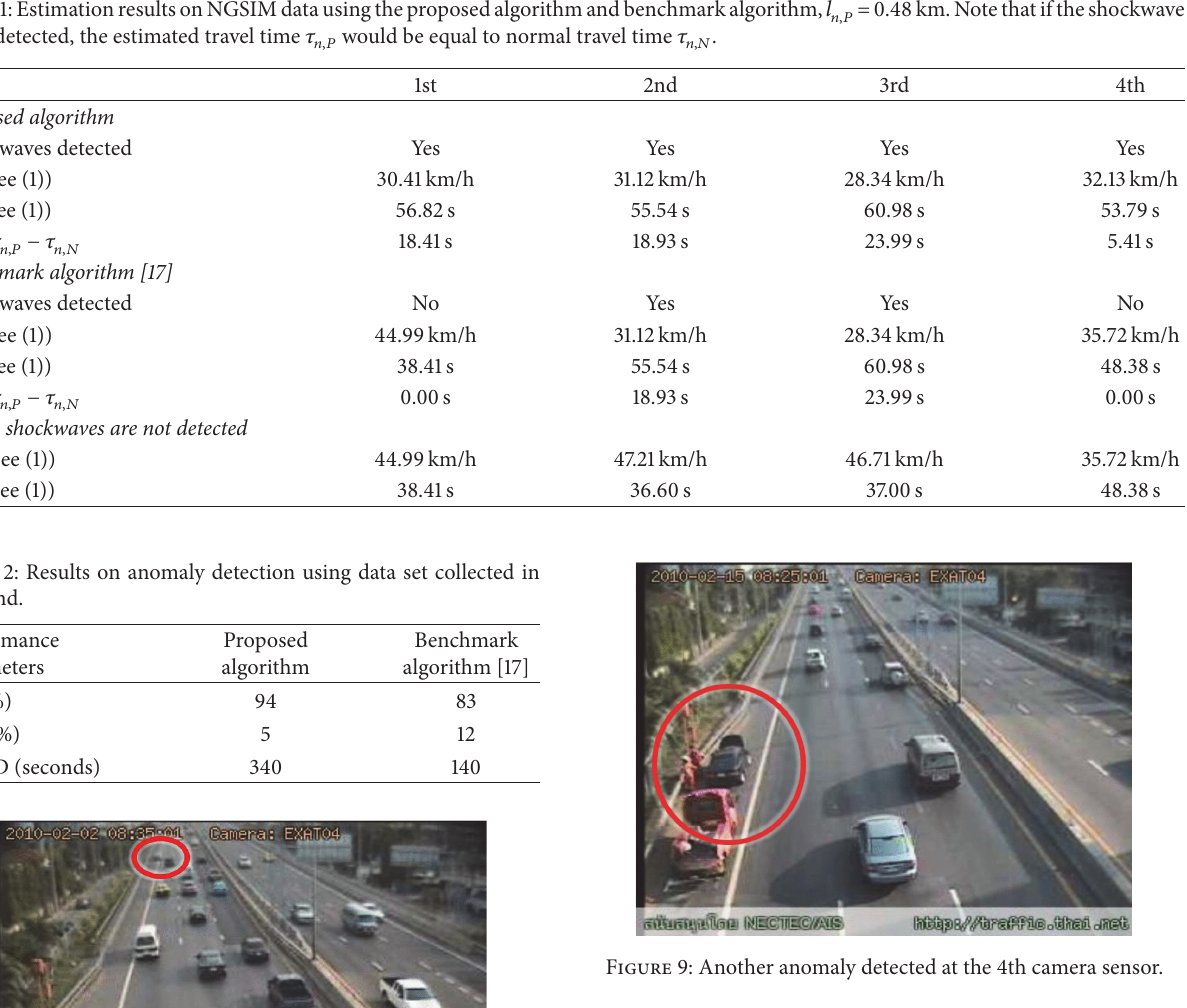
Table1:EstimationresultsonNGSIMdatausingtheproposedalgorithmandbenchmarkalgorithm, 𝑙 𝑛,𝑃 =0.48 km.Notethatiftheshockwave